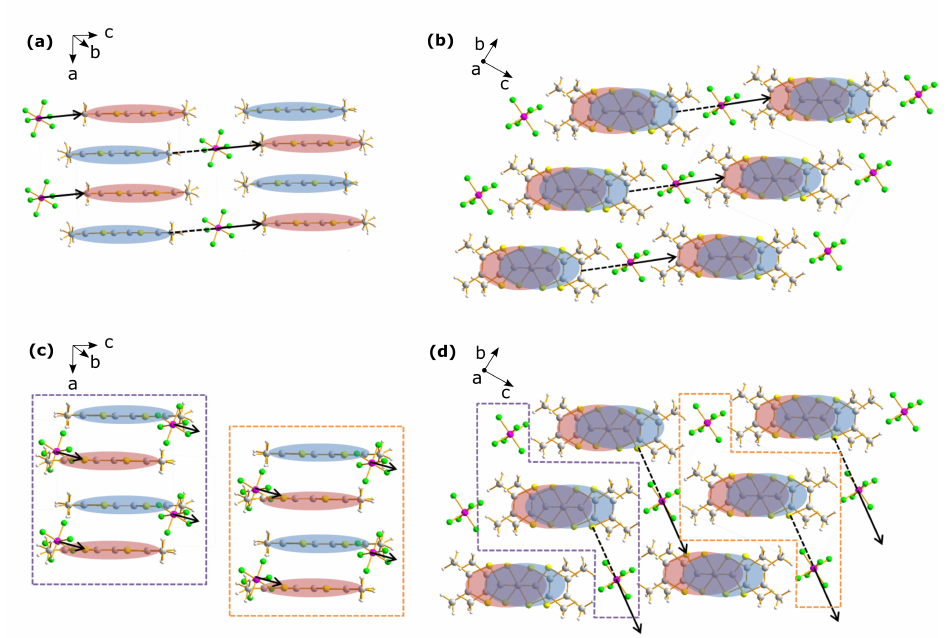
Figure 3. The anions shift along the b + c direction towards the methyl groups and towards the sulfur atoms, as suggested by Pouget [17]. Charge-rich TMTTF molecules are indicated by a red ellipsoids whereas blue ellipsoids mark charge-poor molecules. ( a ) View in the ac -plane and ( b ) along the a -axis onto the cb -plane. The shift of the anions towards the S-atoms of the nearest TMTTF molecule depicted ( c ) in the ac -plane and ( d ) in the cb -plane. The polygons formed by the purple and orange dashed lines in panel d indicate which anion stacks are shown in the previous frame